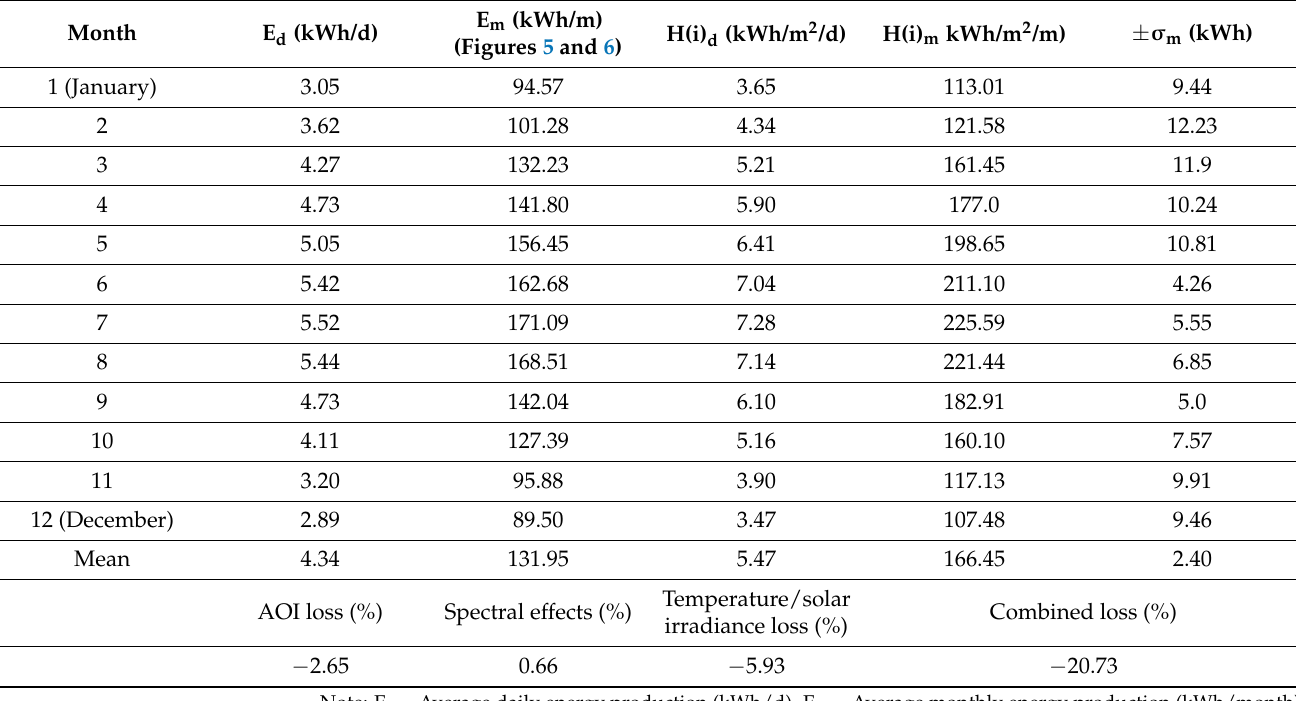
Table 2. PV energy production values processed by database [35].